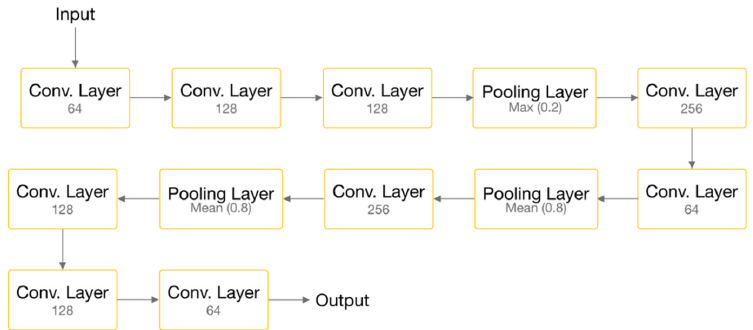
Figure 5. Building block-based CNN architecture with the best validation performance: fully con- volutional network architecture with nine convolutional layers, one max pooling layer and two mean pooling layers.